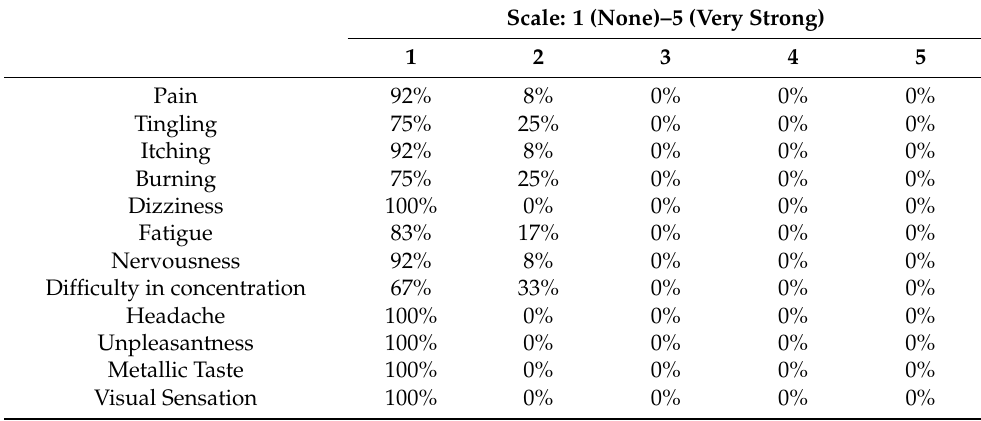
Table 3. Adverse effects post-test questionnaire